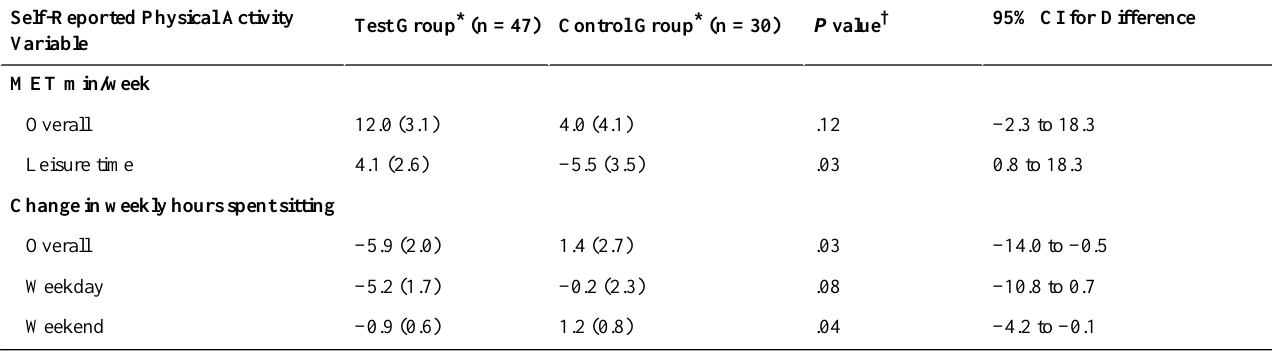
Table 2. Self-reported physical activity in test and control